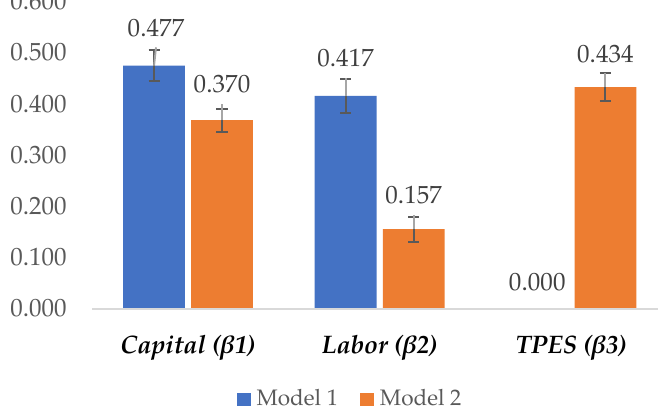
Figure 2. Factor elasticities of production in Models 1 and 2.